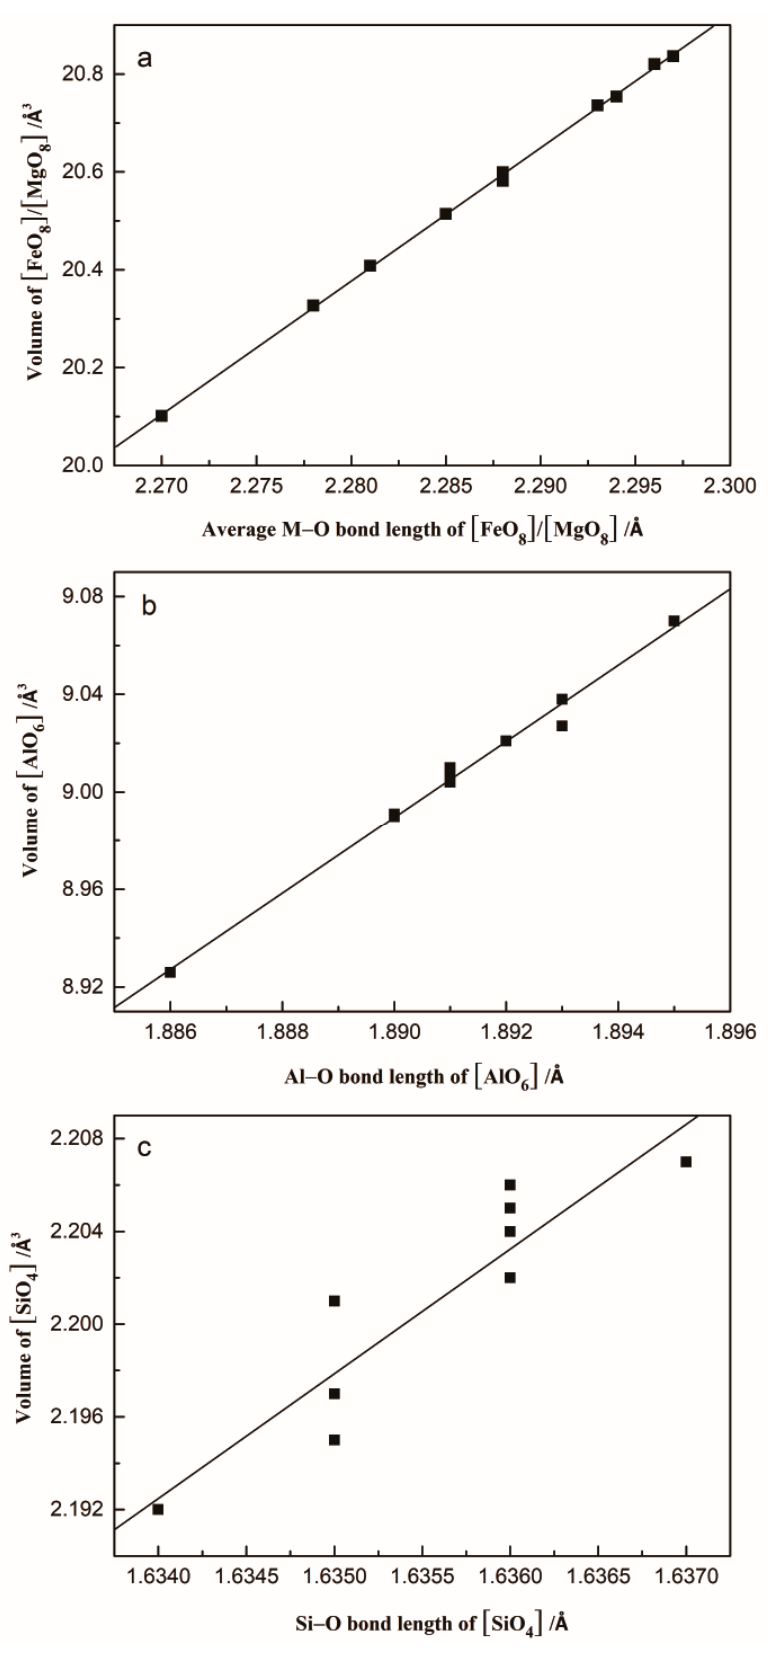
Figure 8. The polyhedron structural variations across the Alm-Pyr solid solutions. ( a ). The volume versus average M-O bond length of [MgO 8 ] / [FeO 8 ] dodecahedron, M represents the Mg 2 + or Fe 2 + ; ( b ). The volume versus Al-O bond length of [AlO 6 ] octahedron; ( c ). The volume versus Si-O bond length of [SiO 4 ] tetrahedron. Linear solid trend lines are fitted to